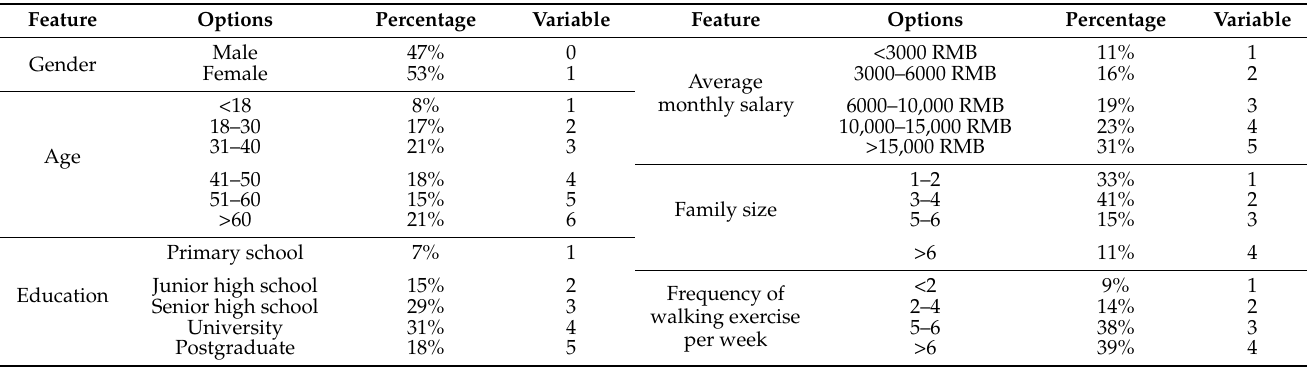
Table 1. Socioeconomic attributes of the survey